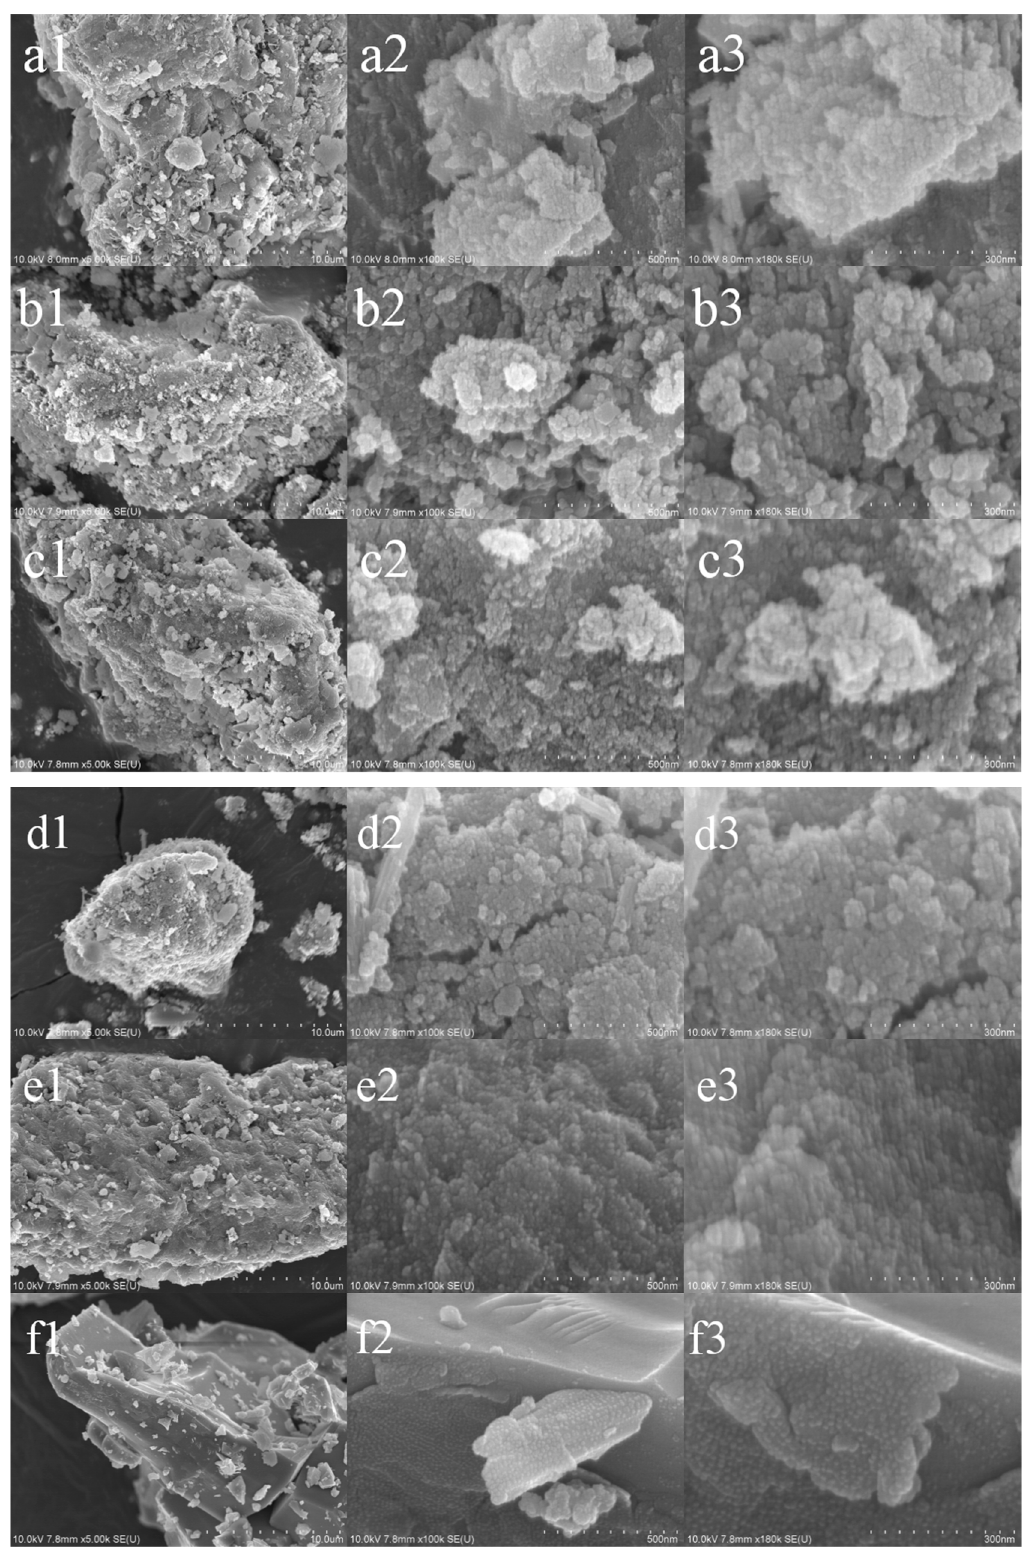
Figure 5. SEM images of CATs unloaded after time on stream for 3–4 years or deactivated for other reasons: ( a ) 4 years; ( b ) 3 years ( c ) caked 1; ( d ) caked 2; ( e ) water soaked ( f ) sintered.